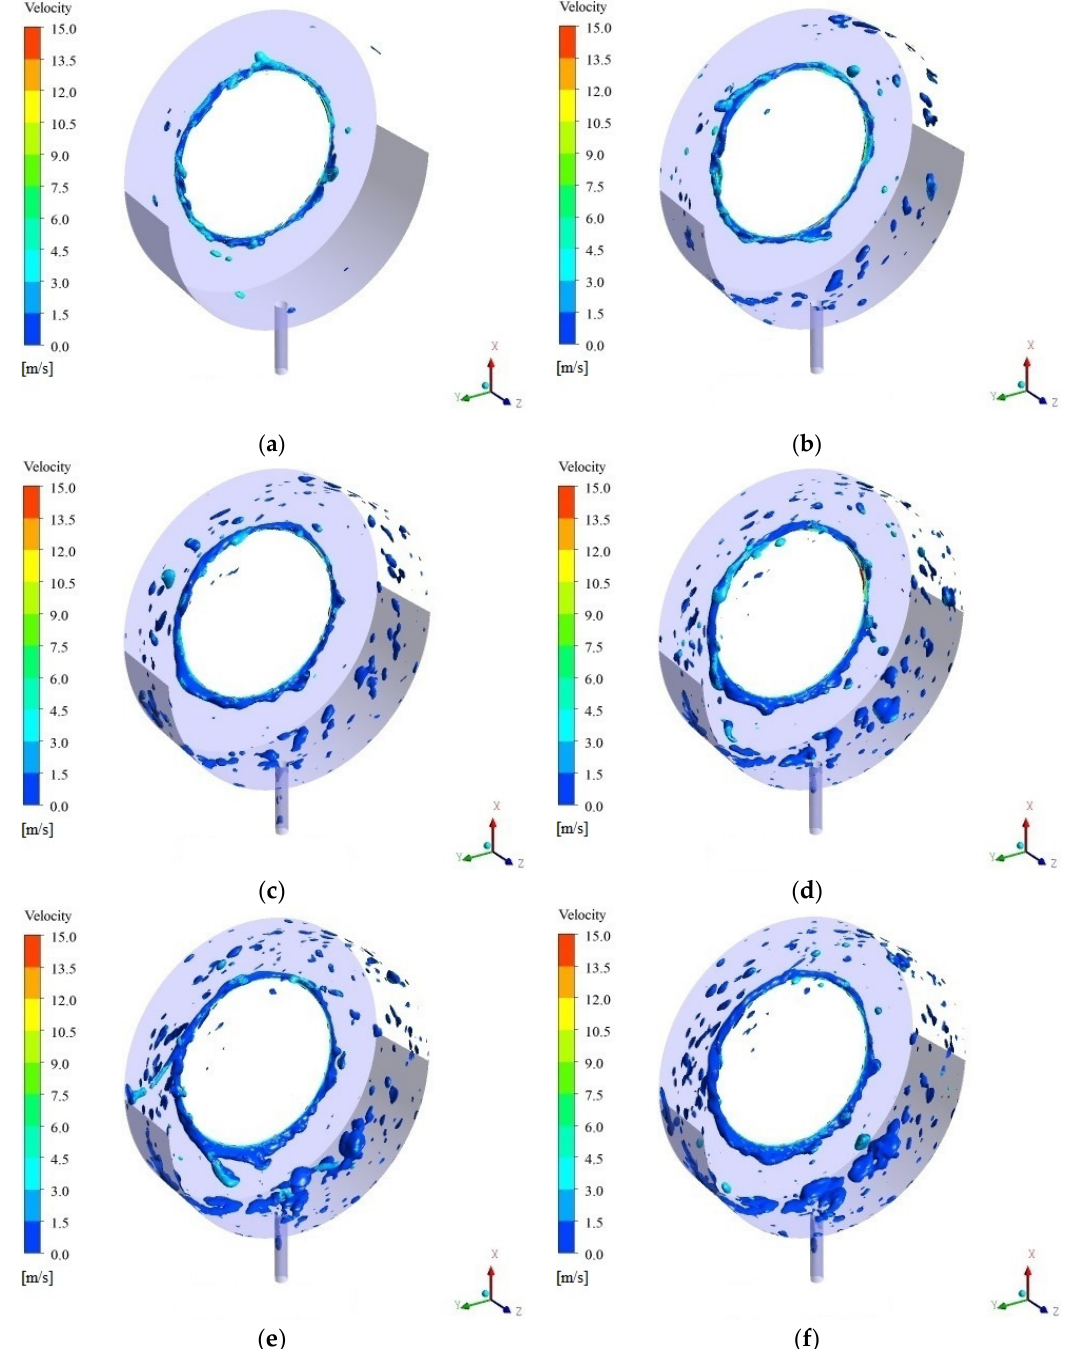
Figure 14. Distributions ( α = 0.25) and velocity fields of oil phase at 10,000 rpm over time: ( a ) t = 0.243 s; ( b ) t = 0.448 s;( c ) T = 0.648 s; ( d ) t = 0.847 s; ( e ) t = 1.057 s; ( f ) t = 1.142 s.